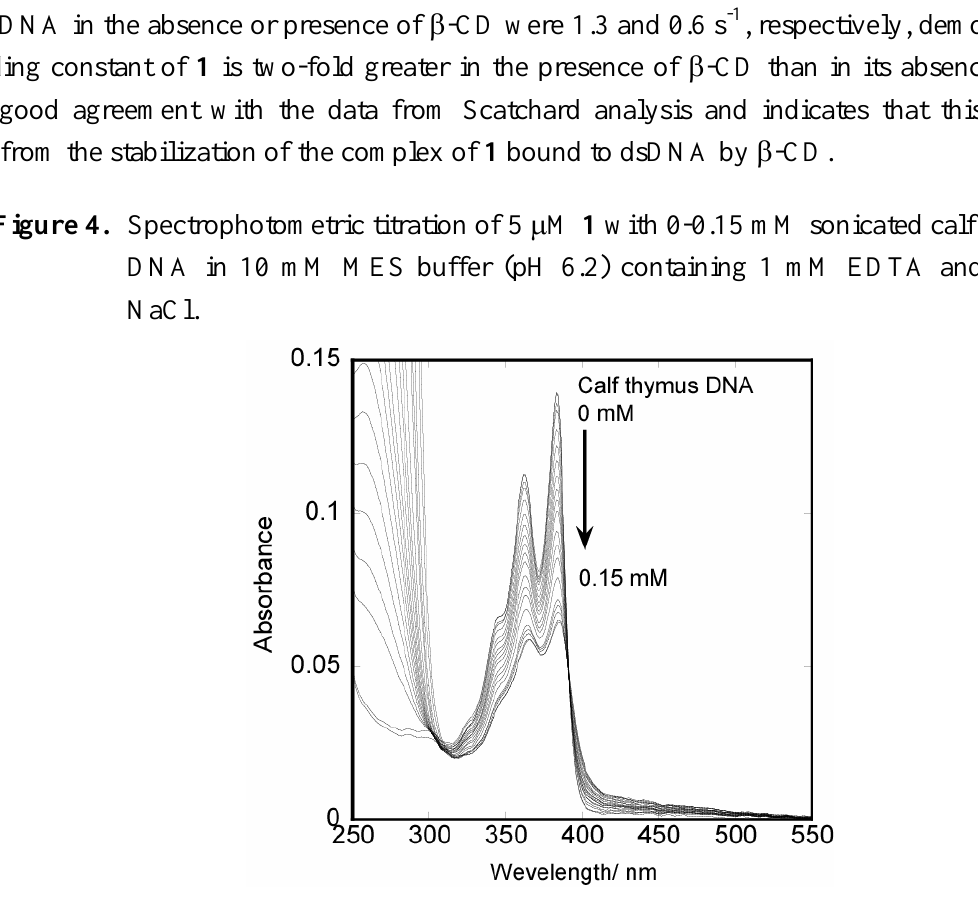
Figure 5. Scatchard plots for 5 µ M 1 with sonicated calf thymus DNA in the absence (a) or presence of 80 µ M β -CD (b, c) in 10 mM MES buffer (pH 6.2) containing 1 mM EDTA and 0.1 M